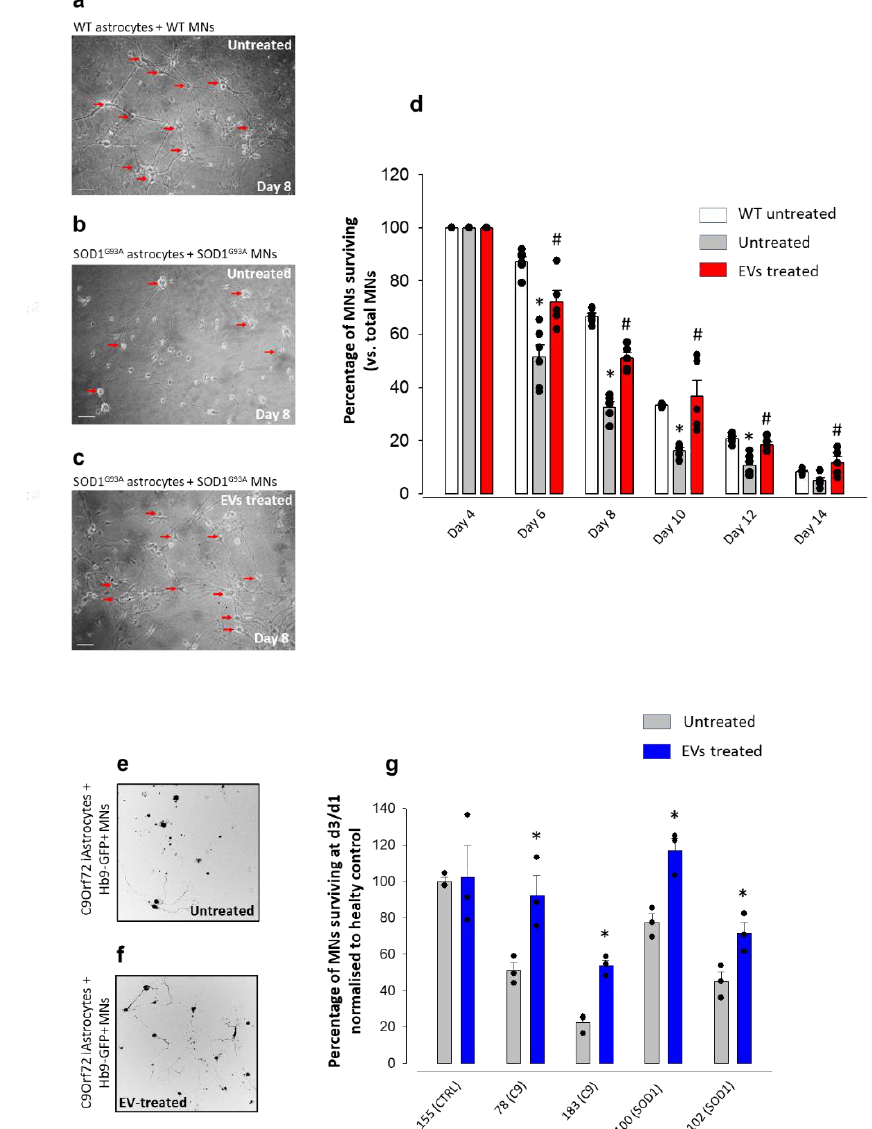
Figure 1. Astrocyte toxicity to motor neurons is reduced when astrocytes are pre-treated with MSC- derived EVs. ( a – d ) Viability of motor neurons (MNs) co-cultured with WT astrocytes, untreated ( b ) and EV-treated ( c ) spinal cord astrocytes from adult SOD1 G93A mice. ( a , c ) Representative phase- contrast microscopy images (100 × ) of MNs at day 8 of co-culture with WT astrocytes ( a ), untreated SOD1 G93A astrocytes ( b ) or with SOD1 G93A astrocytes pre-treated for 24 h with EVs ( c ); scale bar: 50 µ m. ( d ) Quantification of MN viability expressed as percent (%) MN survival (calculated with respect to the total number of MN at day 4 in vitro -4DIV) when co-cultured with WT astrocytes, untreated or EV-treated SOD1 G93A astrocytes. Data represent the means ± SEM of n = 5–6 indepen- dent experiments. Statistical significance for p < 0.05 at least (* vs. WT and # vs. MNs + untreated SOD1 G93A astrocytes; one-way ANOVA, followed by Bonferroni post hoc test). ( e – g ) Viability of MNs co-cultured with untreated and EV-treated patient-derived reprogrammed astrocytes (iAstro- cytes). ( e , f ) Representative InCell images of MNs after 3 days of co-culture with iAstrocytes, un- treated ( e ) or treated ( f ) with human-MSC-derived EVs. ( g ) Quantification of MN survival expressed as the percentage of MNs with axon (calculated with respect to the total number of MNs at day 1) after 3 days of co-culture with iAstrocytes untreated or pre-treated with EVs. Data represent the means ± SEM of n = 3 independent experiments. Statistical significance (*) vs. untreated conditions